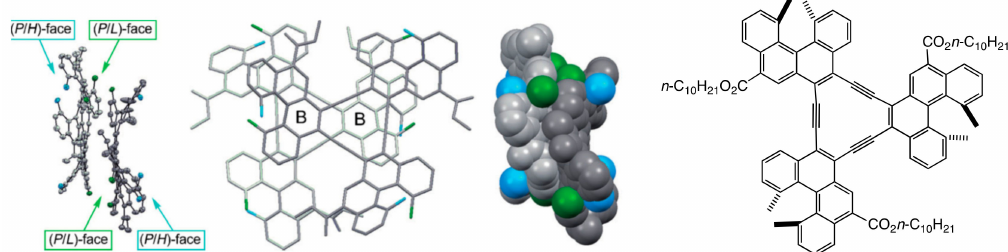
Figure 11. X-ray structure of dimeric ( P )-[3]alkyne. Reproduced from reference 53 by permission from John Wiley & Sons, Hoboken, NJ, USA.